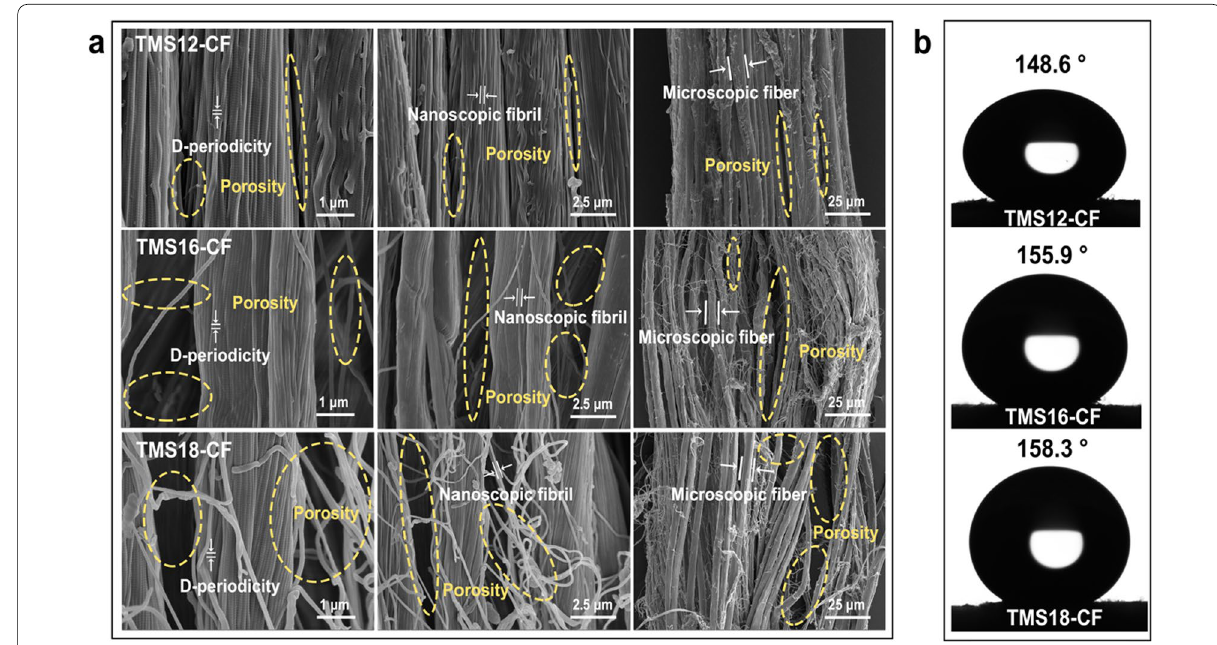
Fig. 4 SEM images of TMSx-CF ( a ), and WCAs of TMSx-CF ( b